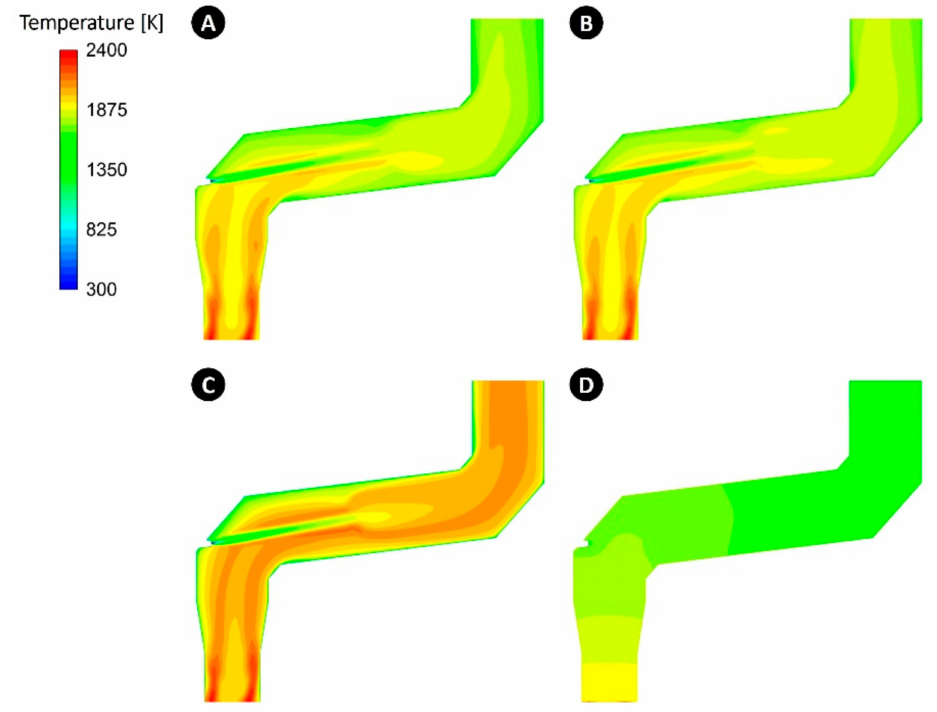
Figure 16. Predicted contour of temperature for DOM ( A ), P1 ( B ), no radiation ( C ), and Rosseland ( D )